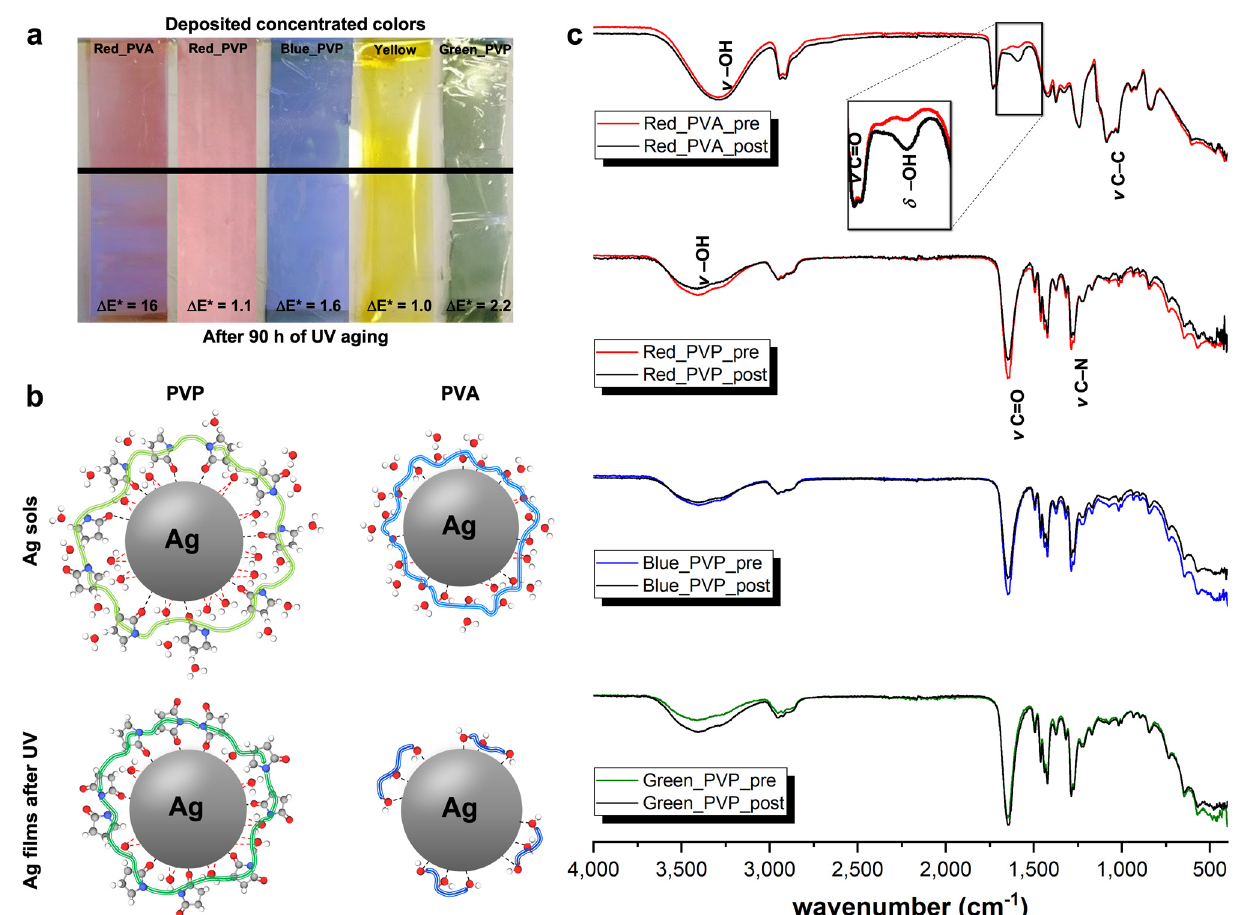
Figure 2. ( a ) Deposited Ag sols on crown-treated PET films showing the eventual color variation ( Δ E*) upon 90 h UV treatment (lower part). ( b ) Diagram representing both PVA- and PVP-Ag interactions, also upon long-term UV exposure. ( c ) Comparison of FT-IR spectra relative to Red_PVA, Red_PVP, Blue_PVP and Green_PVP colored films, before and after UV aging test. Inset: magnified area between ca. 1700 and 1400 cm − 1 evidencing the difference in FT-IR spectra features only for Red_PVA sample.